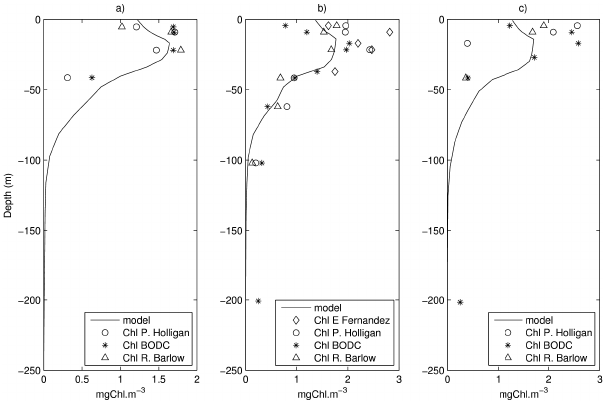
Fig. 8. Vertical distribution of Chl a (mg Chlm − 3 ) at stations 14 (a) , 15 (b) , and 16 (c) . The black solid line represents the simulated field (averaged May over 8yr). The markers represent the estimations made during the AMT 6 cruise, in May 1998, from four different sources (E. Fernandez for the diamonds, P. Holligan for the circles, the British Oceanographic Data Centre for the stars, and R. Barlow for the